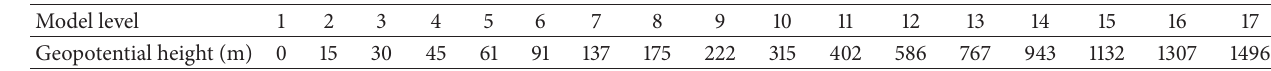
Table 3: Model levels and their corresponding